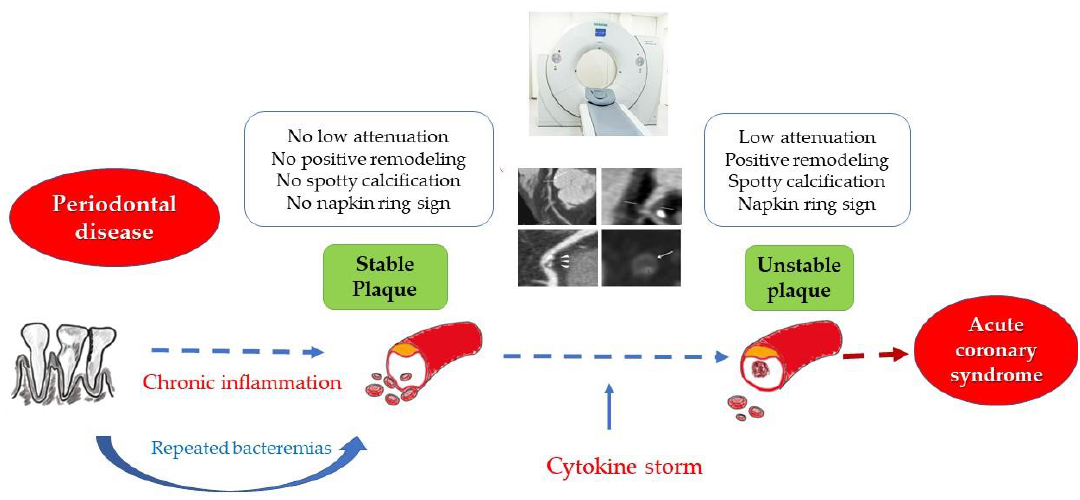
Figure 1. The link between periodontal disease, chronic inflammation and plaque